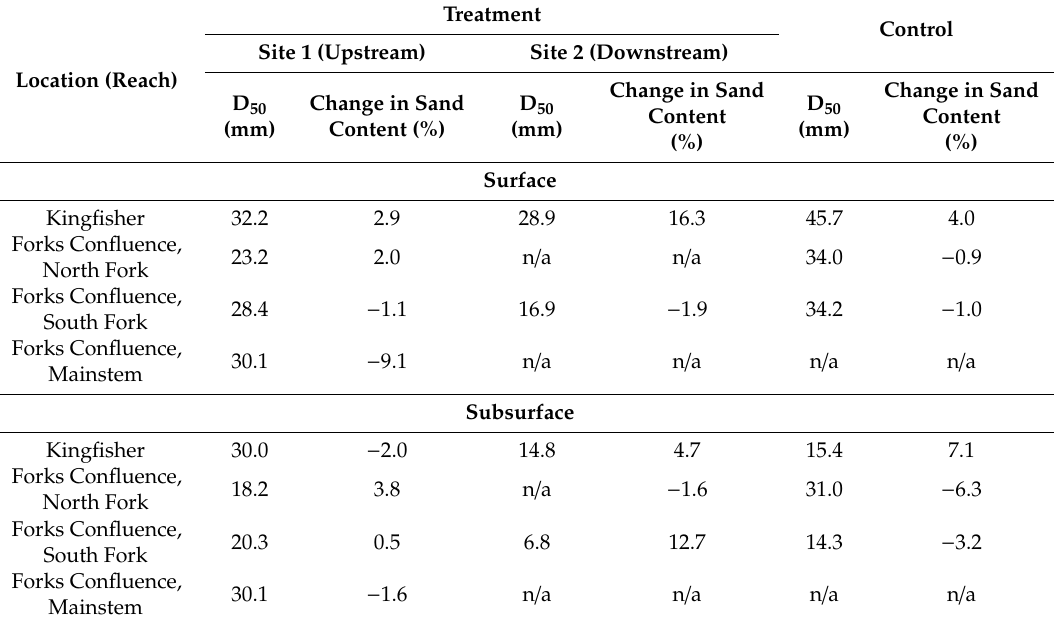
Table 5. 2017 median grain size, D 50 , (in mm) and percent change (all grain sizes < 2mm) 2016–2017 (2015–2017 for the three Kingfisher